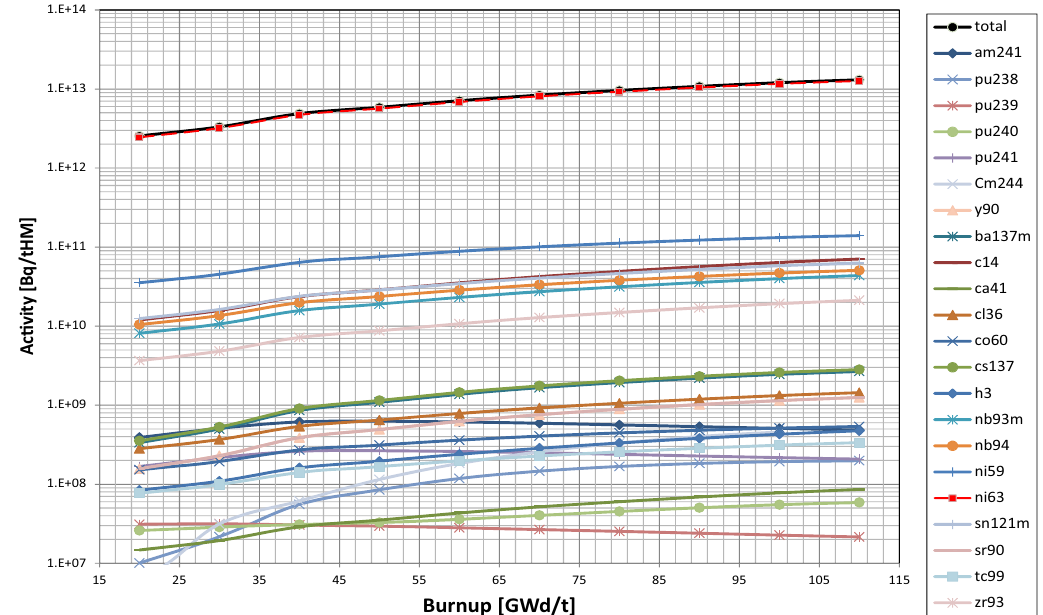
Fig. 3. Actinide, activation product and fi ssion product activities as a function of fuel burnup, decay-corrected up to 100